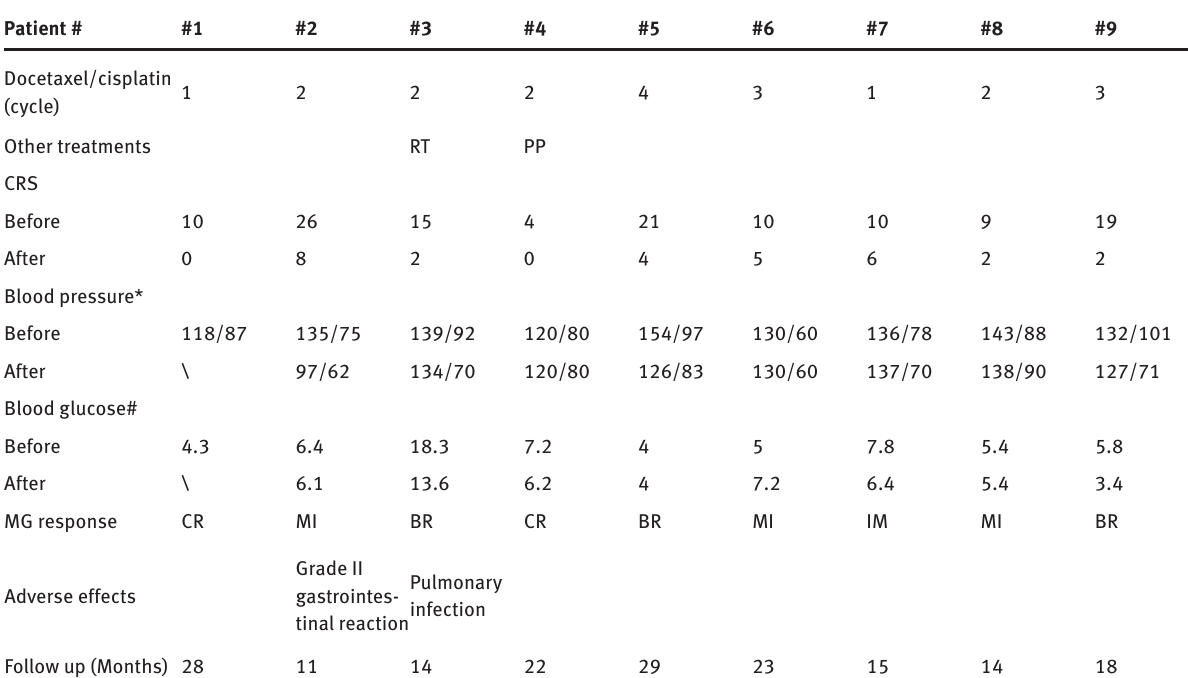
Table 2: Outcome of patients after docetaxel plus cisplatin therapy.